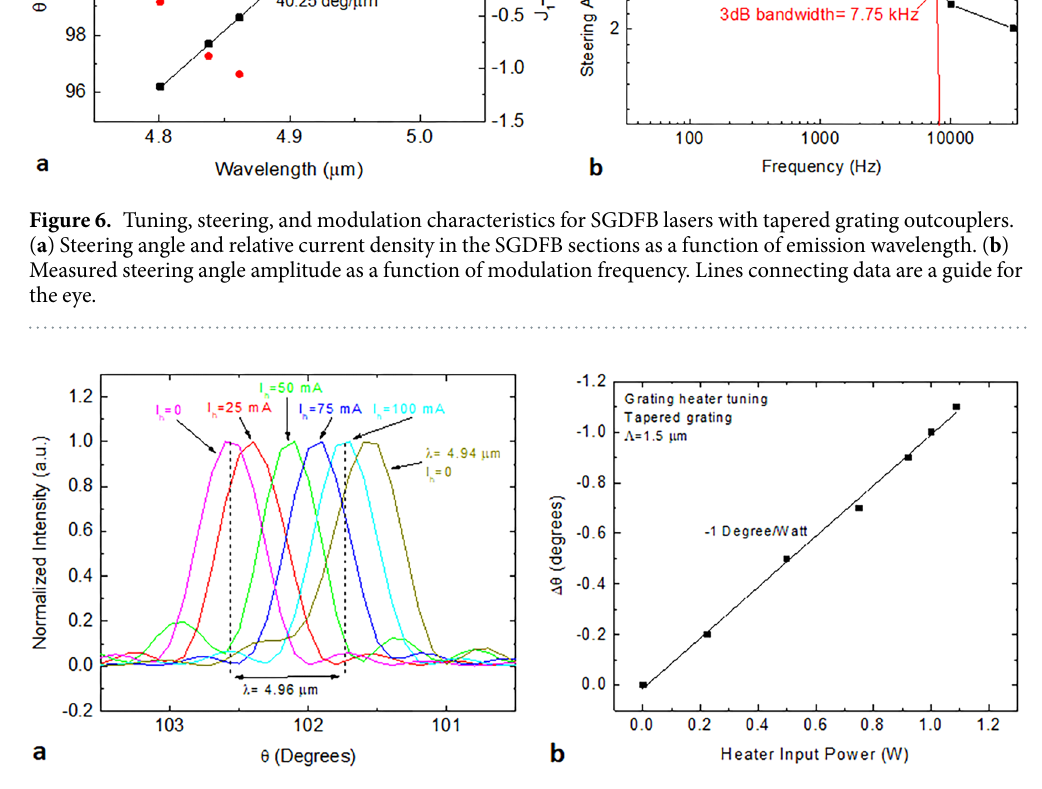
Figure 7. Grating heater tuning characteristics. ( a ) A collection of far-field scans along the theta axis ( φ = 0) for different heater current, I h , values and input wavelengths. ( b ) Change in steering angle as a function of the input power to the grating